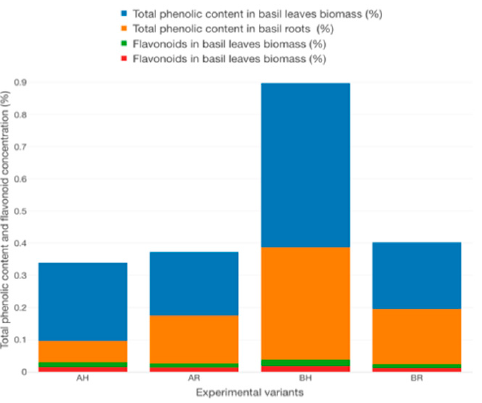
Figure 30. The total phenolic content and flavonoids concentration in basil roots and leaves biomass growth in each of the experimental variants.